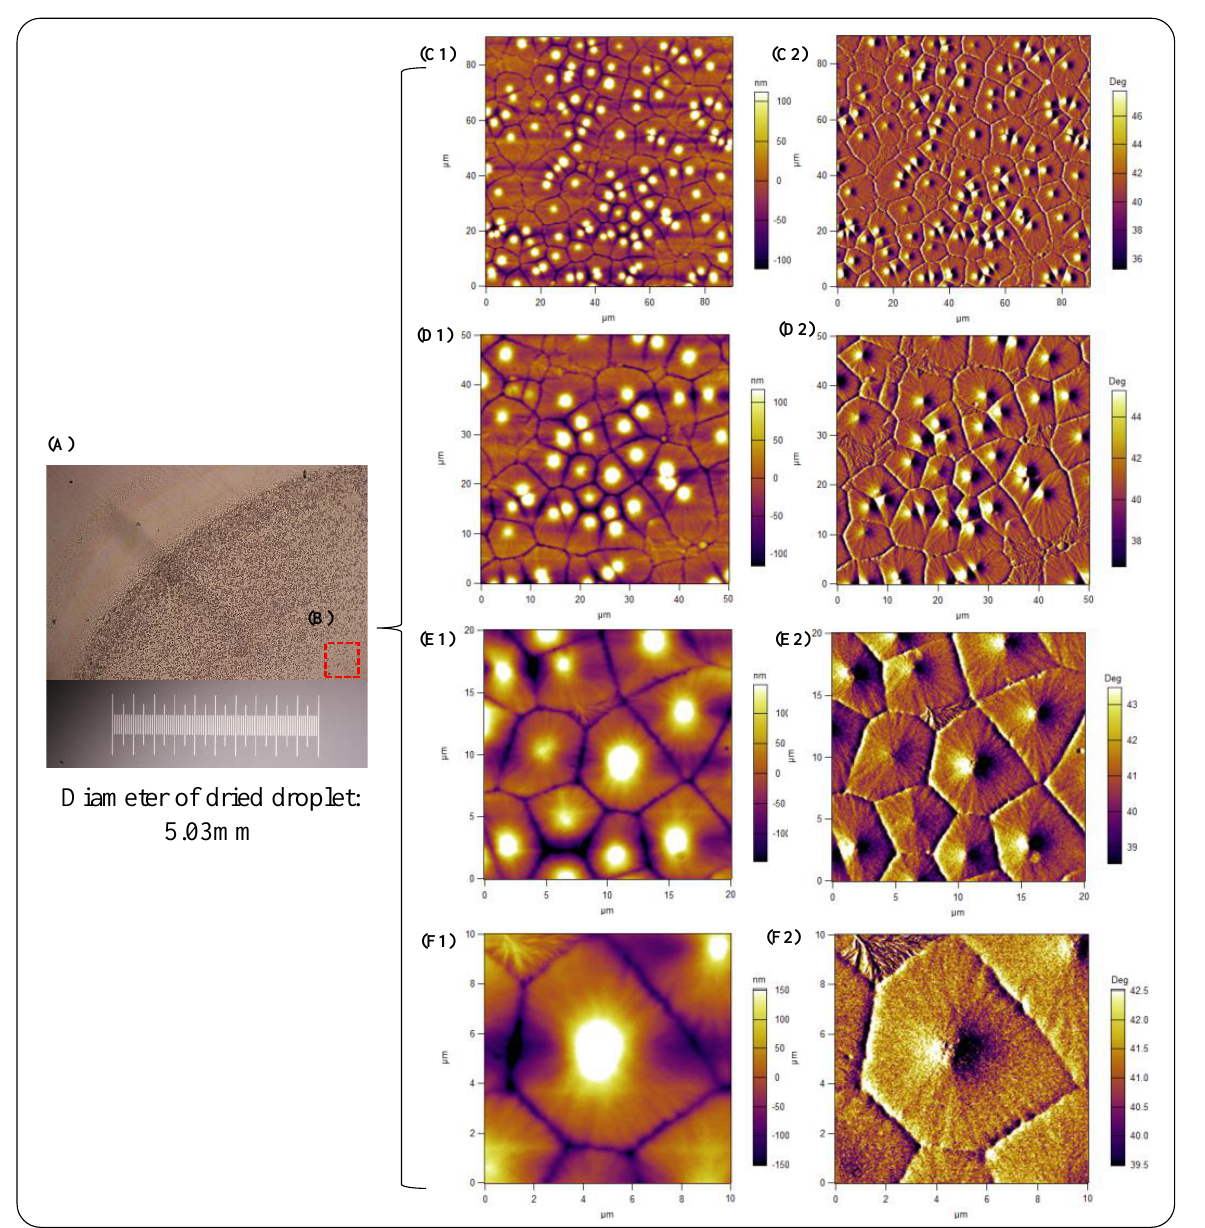
Figure 2. ( A ) Optical microscopy image of a dried PVDF/DMF solution droplet about 5.03 mm in diameter. ( B ) AFM images of center region of dried PVDF/DMF solution droplet. ( C – F ) AFM height and phase images dried PVDF/DMF solution droplet. ( 1 ) height image, ( 2 ) phase images, ( C ) 90 μm × 90 μm; ( D ) 50 μm × 50 μm; ( E ) 20 μm × 20 μm; ( F ) 10 μm × 10 μm.